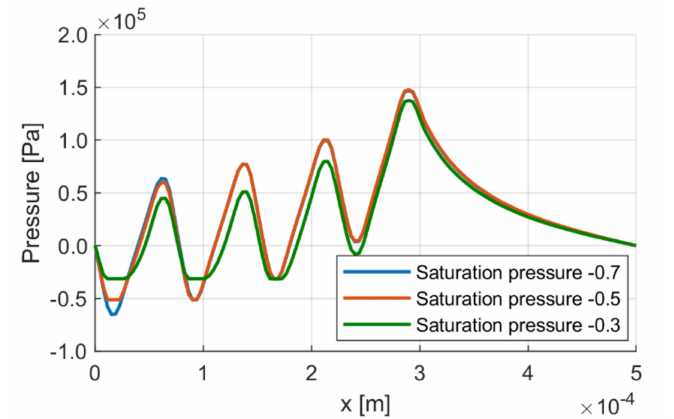
Figure 22. Pressure profiles calculated along the dimples median line, considering di ff erent saturation pressure values. Square dimples with side 50 µ m and gap 8 µ m, sliding velocity 10 m / s. Set A of the cavitation coe ffi